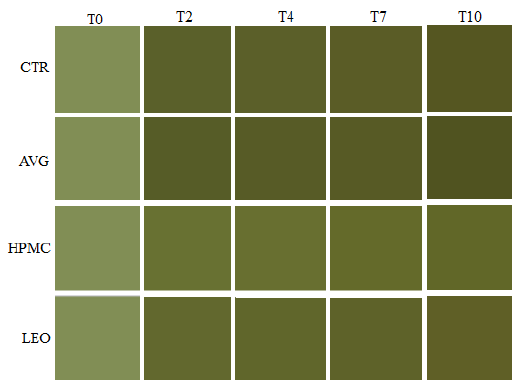
Figure 2. Color table obtained from the results of the total color difference (∆E) recorded in the CIE L*a*b* color space and converted to the red/green/blue (RGB) scale through the www.e-paint.co website. This figure shows the differences between the coated (AVG, HPMC and LEO) and uncoated (CTR) kiwifruit slices at day 0 and after 2, 4, 7 and 10 days of cold storage at 4 ± 1 °C and 90% ± 5% relative humidity (RH) in dark conditions. Abbreviations: CTR, uncoated fruit slices, AVG, fruit slices coated with 40% v/w of Aloe vera gel only, HPMC, fruit slices coated with 40% v/w of Aloe vera gel + 0.1% v/w of hydroxypropyl methylcellulose and LEO, fruit slices coated with 40% v/w of Aloe vera gel + 0.1% v/w of lemon essential oil.